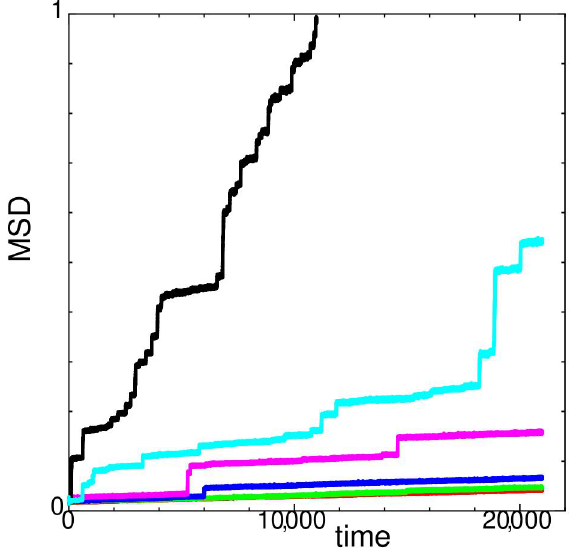
Figure 3. Mean square displacement (MSD) of state G at temperatures T = 114 (red), 122 (green), 126 (blue), 128 (magenta), 132 (cyan), and 136 (black) for system size N =